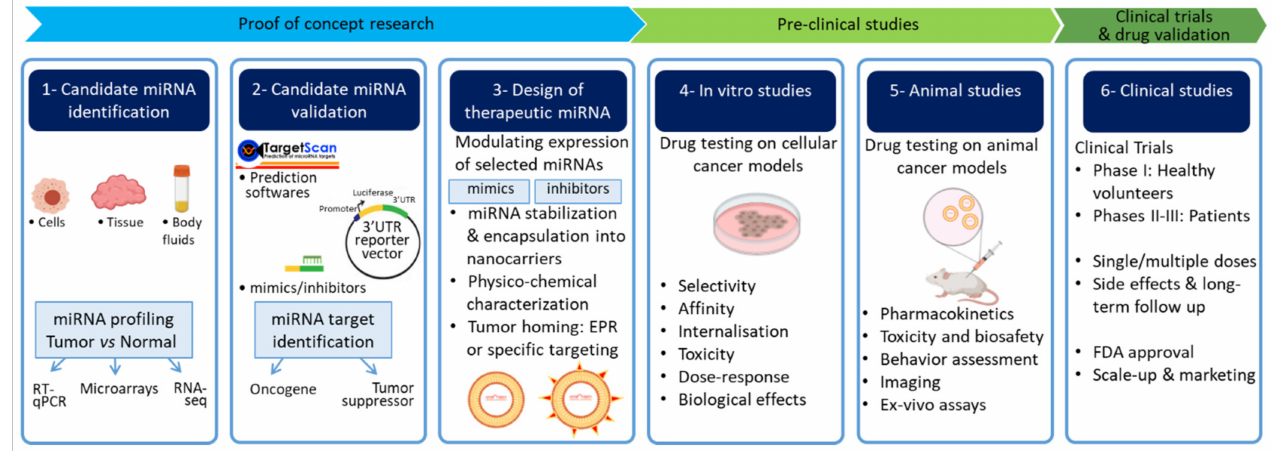
Figure 1. Translating miRNA biology from bench to bedside in cancer. As for the classical drug discovery workflow, development of miRNA therapeutics consists of 3 main levels: proof of concept research, preclinical studies, and clinical trials. ( 1 ) Identification of candidate miRNAs for therapy. MiRNA expression is quantified in tissue, cells, or body fluids of healthy and tumor specimens (RT-qPCR: Reverse Transcription-quantitative PCR; RNA-Seq: RNA sequencing). ( 2 )